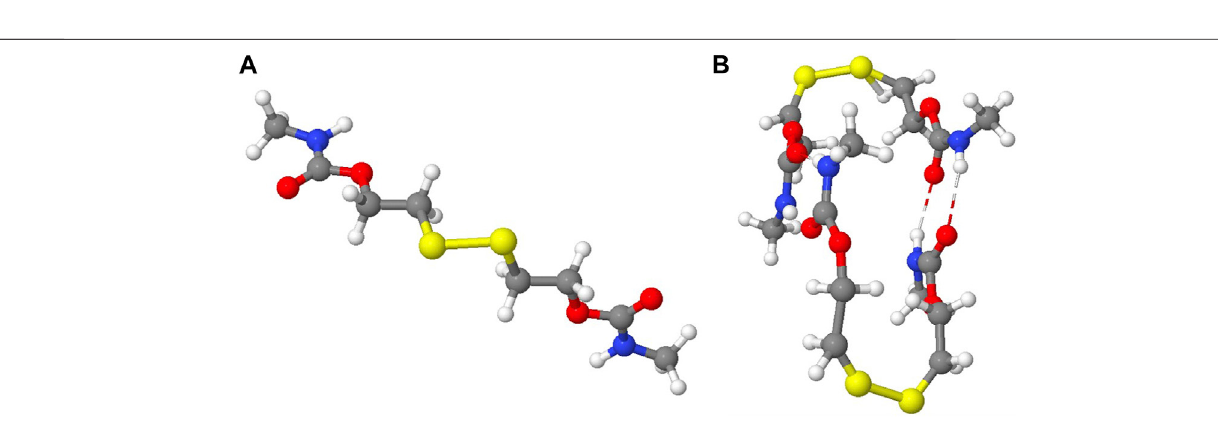
FIGURE 5 | (A) ADSA single-chain model in an open conformation. (B) Interaction between two ADSA chains.